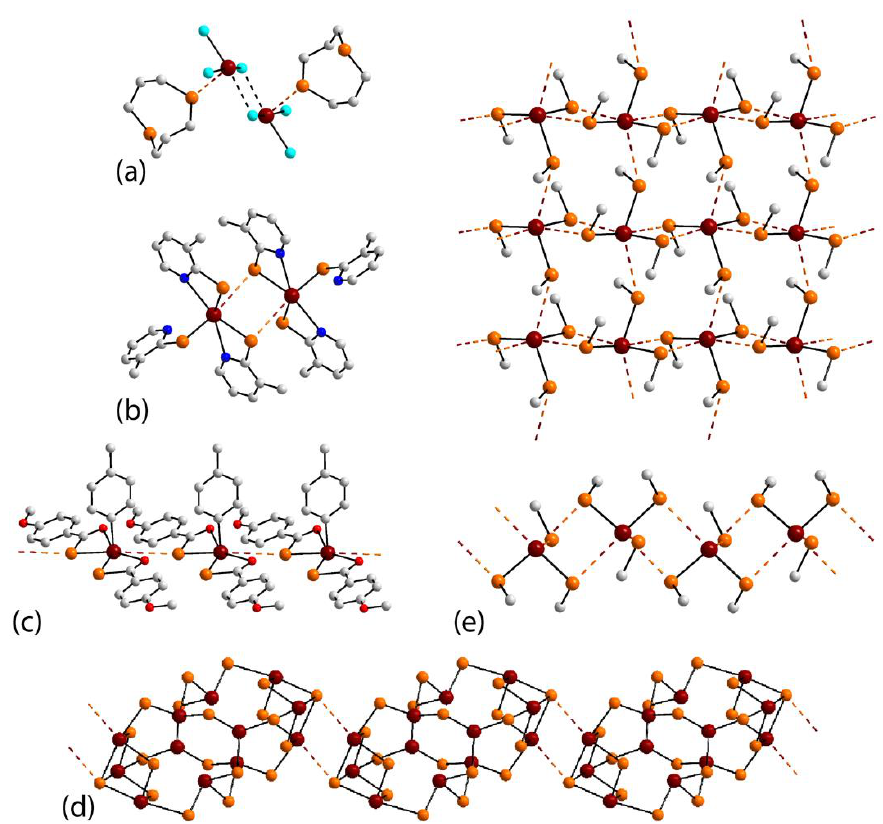
Figure 9. Supramolecular aggregation via Sb ··· Se secondary bonding in ( a ) 28 {EWIWAI; d(Sb ··· Se) = 3.29 Å}, ( b ) 29 {TAKSEF; 3.67 Å}, ( c ) 33 {ACUPAQ; 3.87 Å}, ( d ) 34 {HEFCOK; 3.61 Å}, and ( e ) 35 {JAZGIA; 3.55, 3.64 & 3.66 Å }.